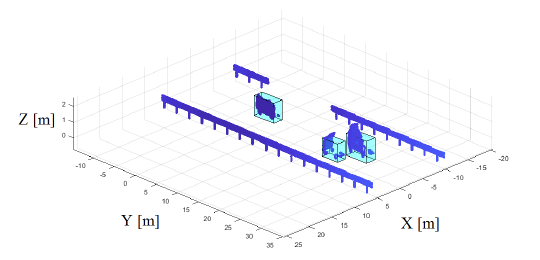
Figure 7. Modeled detection from stationary infrastructure (barriers) and dynamic target vehicles (in bounding